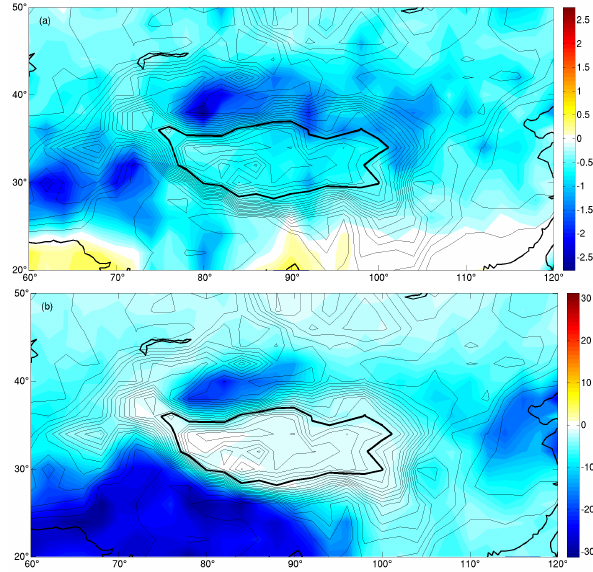
Fig. 8. Downward SW fluxes anomalies due to aerosols at (a) 5km and (b) 0kma.m.s.l. in W/m 2 . Simulation with MODIS surface albedo. Note the different scalings of the colorbars, each time ad- justed to the respective extreme value. The thick lines indicate coasts and the Tibetan